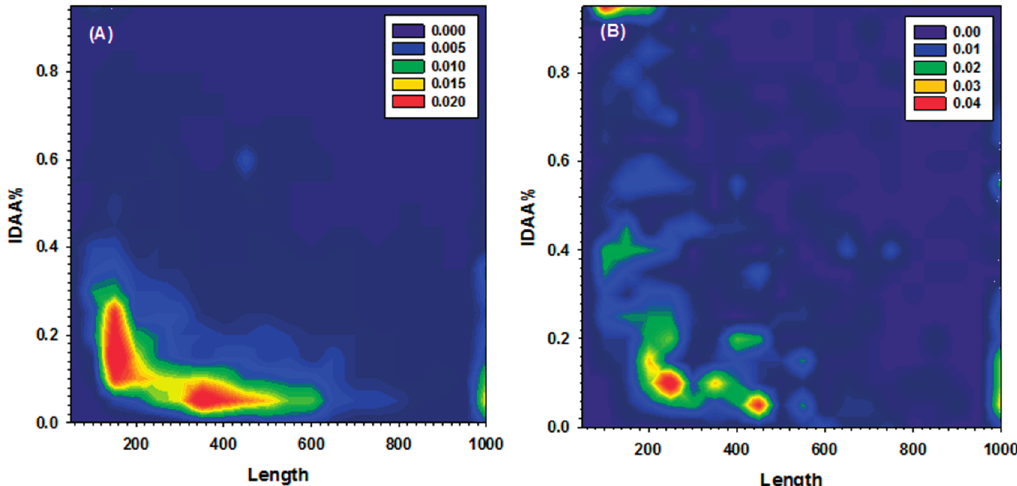
Figure 1. Abundance of proteins as a function of length and fraction of disordered residues (IDAA%) in both ( A ) Yeast and ( B ) DisProt datasets. All protein sequences longer than 1000 residues were merged with into the group of proteins of 1000 residues. The per-residue disorder score was calculated from PONDR-FIT. All residues of which the disorder score is higher than 0.5 were counted as disordered residues. The fraction of disordered residues is the ratio over the length of corresponding protein. Colors from purple, to blue, green, yellow, and red represents the increased